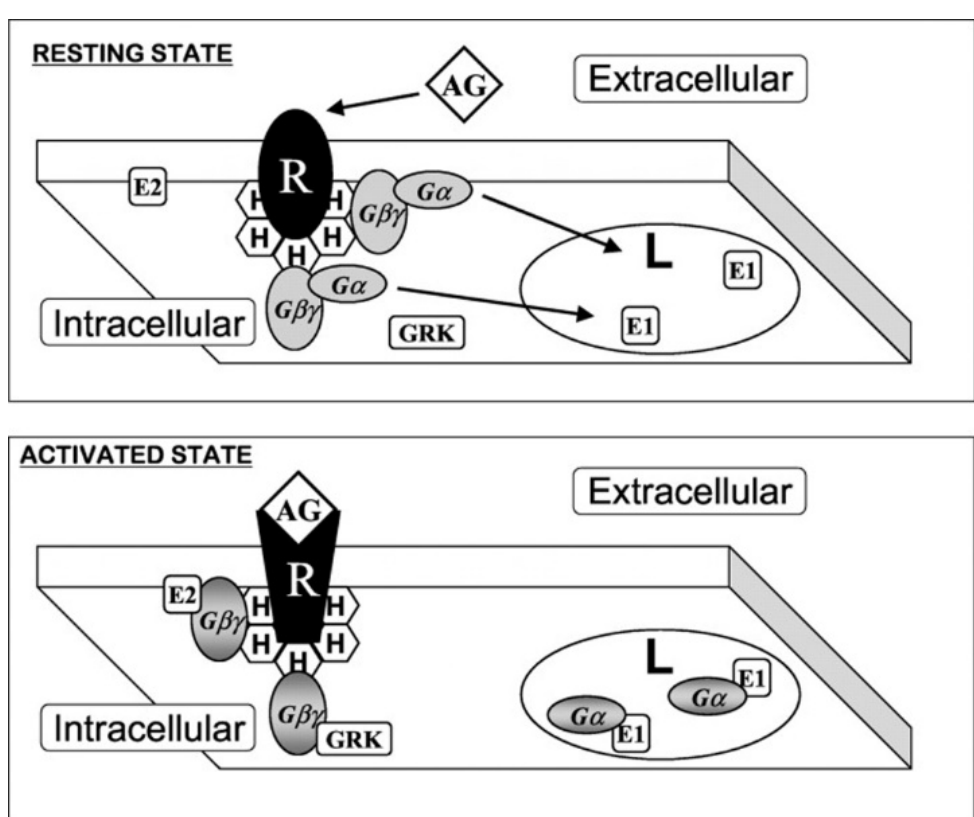
Figure 4. Lipid-Protein-Protein-Lipid (LPPL) interactions, membrane microdomains, and cell sig- naling. Upper panel, the Gαβγ protein is in the pre-active form in nonlamellar-prone membrane microdomains (HII), where it is pre-coupled to transmembrane receptors (R). Lower panel, agonist binding induces activation upon exchange of guanosine diphosphate (GDP) for guanosine tri- phosphate (GTP) in the alpha subunit. The dissociated Gαi1 protein moves to lipid raft domains where it interacts with signaling effector proteins (E1). In contrast, the Gβγ dimer remains in Ld (HII), where it interacts with G protein-coupled receptor kinase (GRK) or other signaling effector proteins (E2). Adapted from [17].